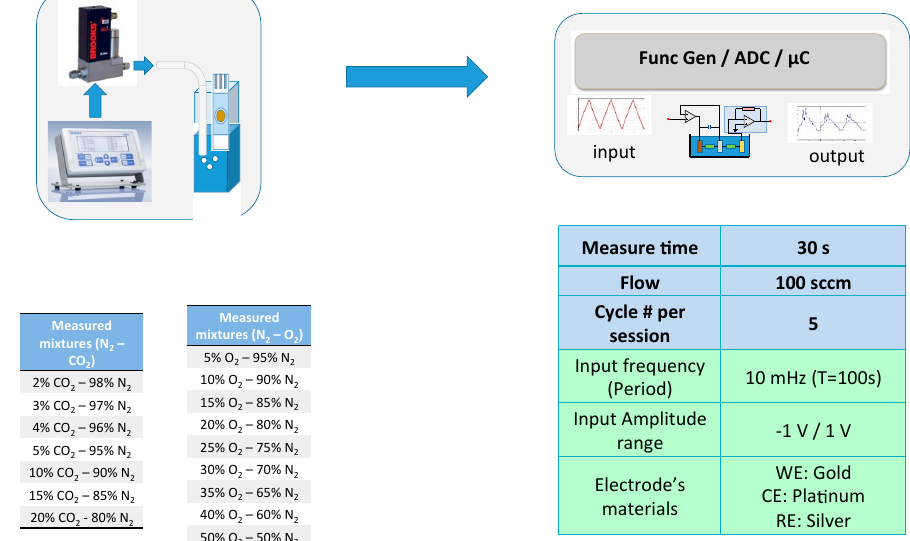
Figure 1. Sampling protocol. Calibration parameters and device settings.